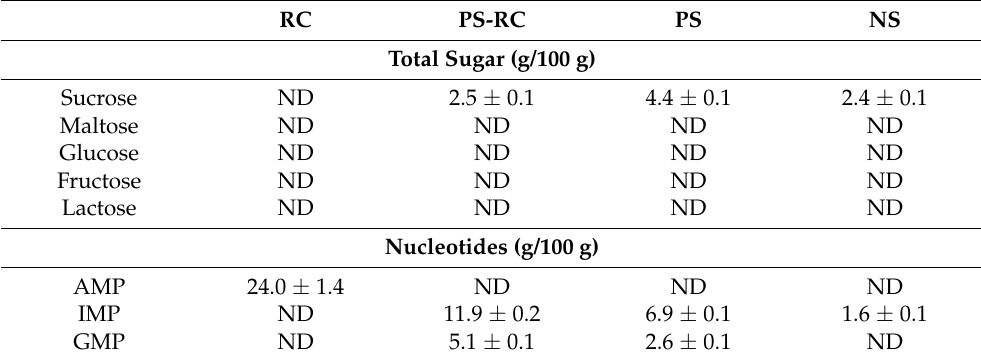
Table 3. Total sugars and nucleotides of snow crab leg meat and commercial imitation crab